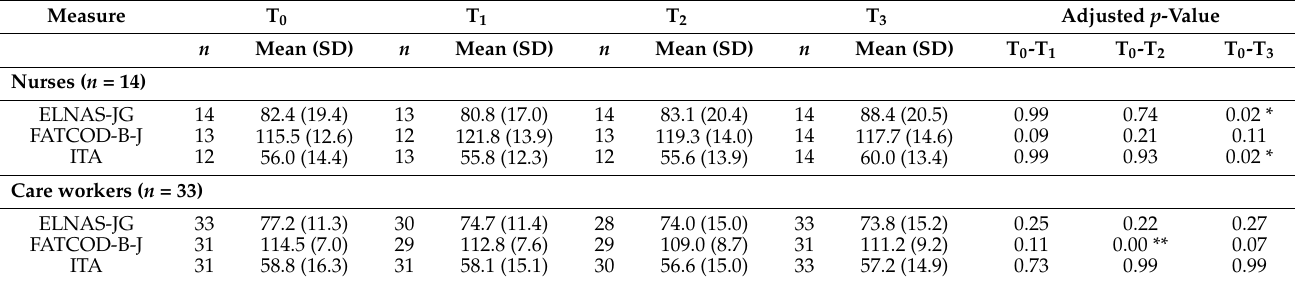
Table 3. Changes in nurses’ and care workers’ attitudes toward end-of-life care and interdisciplinary collaboration with the EOL Care Tool ( n = 47).